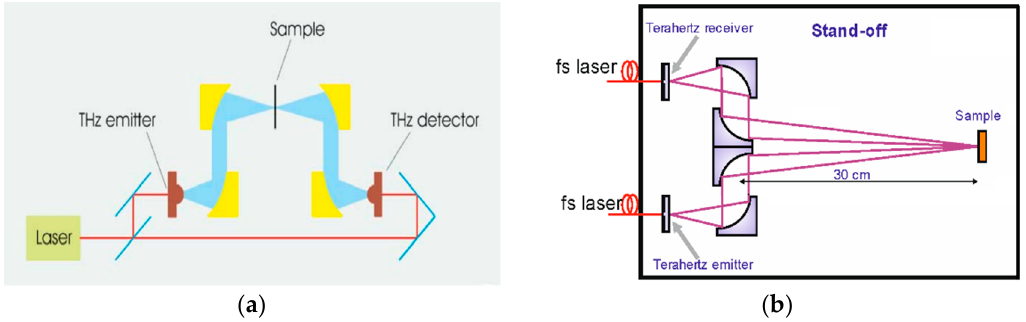
Figure 1. The principal scheme of the system for the transmission ( a ) and reflection ( b ) mode.